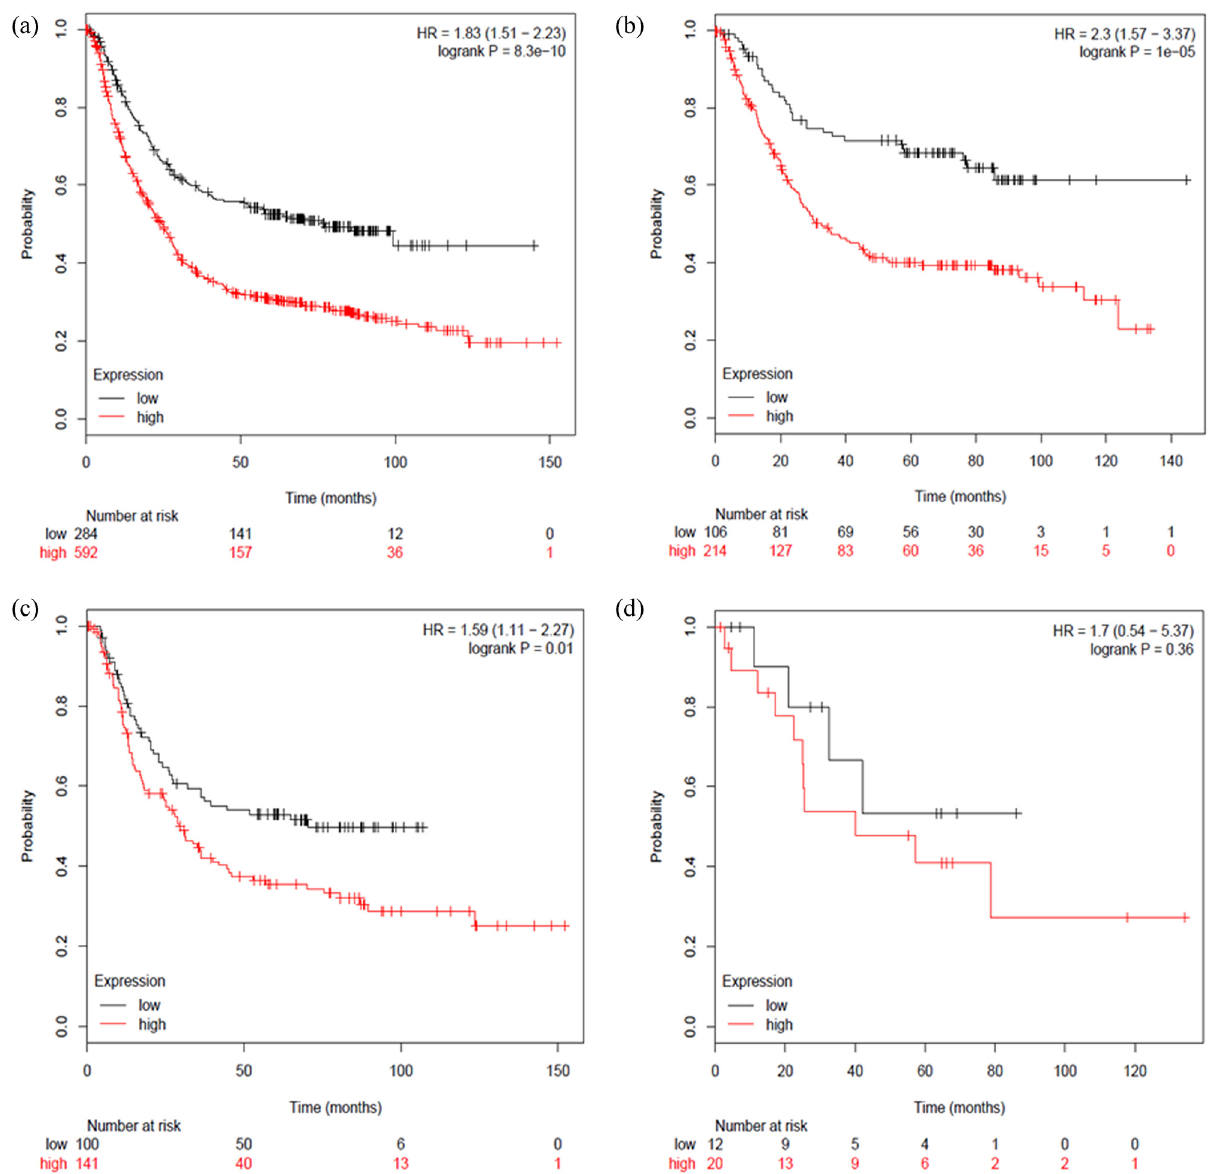
Figure 3: Determination of the prognostic value of ROR β mRNA expression in www.kmplot.com. The desired A ff ymetrix ID is valid: 206443_at ( ROR β ) . ( a ) Survival curves were plotted for all patients with GC ( n = 876 ) . ( b ) Survival curves were plotted for patients with intestinal - type GC ( n = 320 ) . ( c ) Survival curves were plotted for patients with di ff use - type GC ( n = 241 ) . ( d ) Survival curves were plotted for patients with mixed - type GC ( n = 33 )